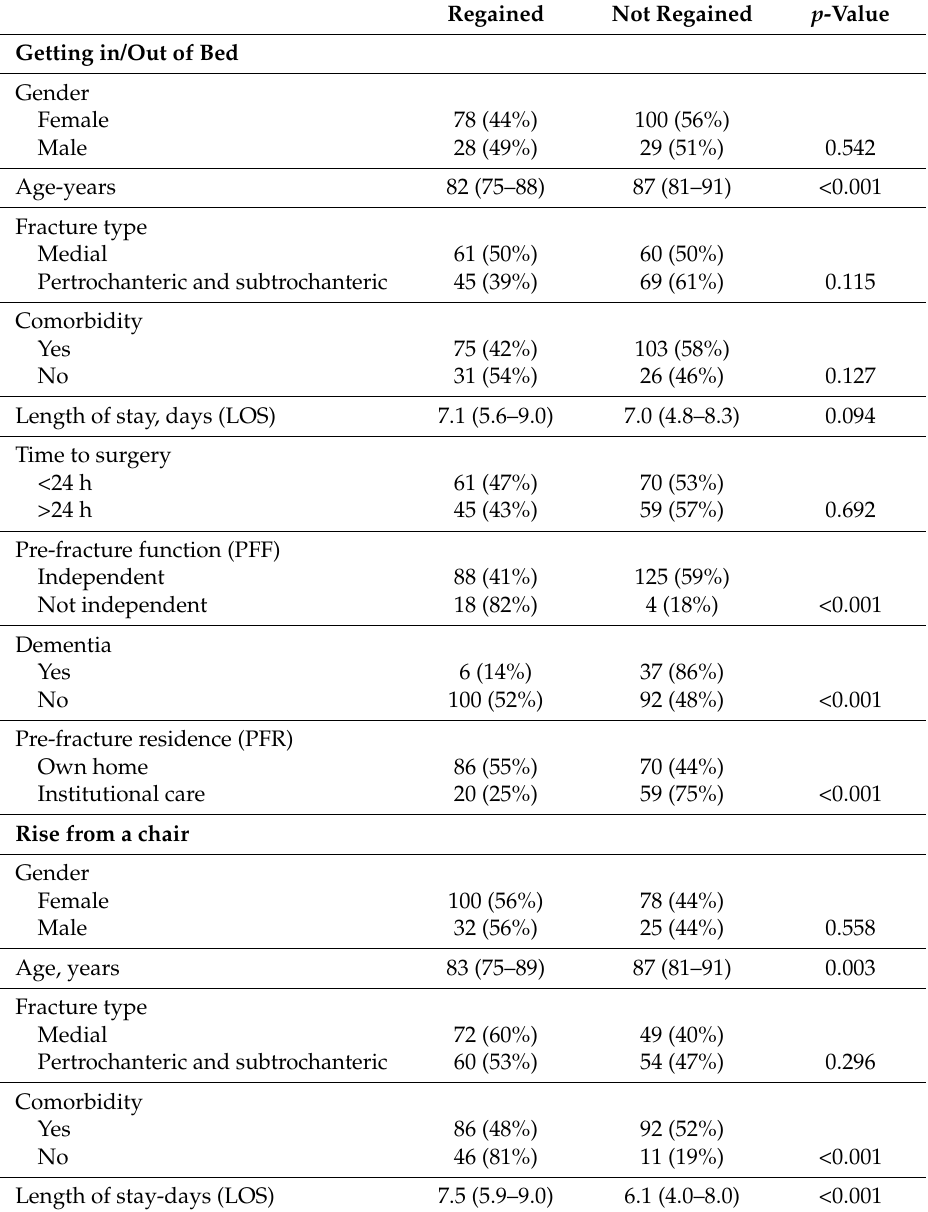
Table 2. Comparison of regained pre-fracture basic mobility status vs. not regained pre-fracture basic mobility status at